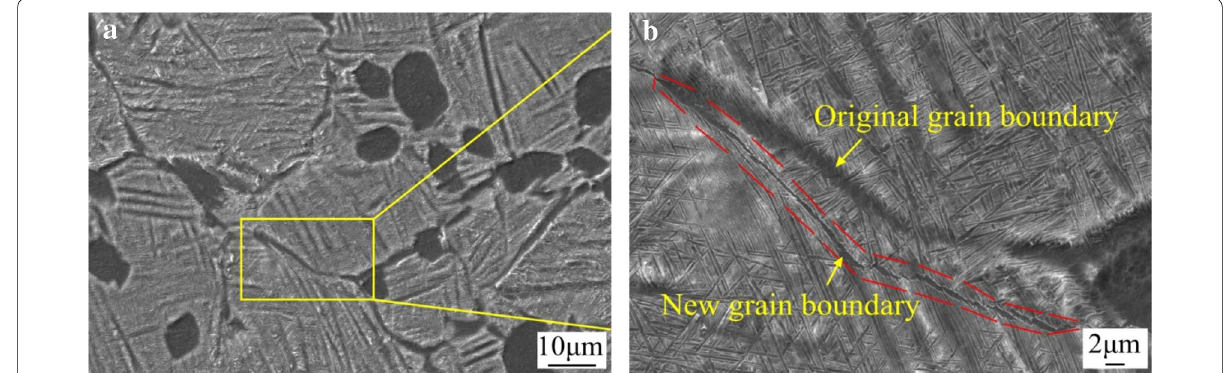
Figure 10 Microstructure characterization of HAZ: a Low magnification, and b High magnification